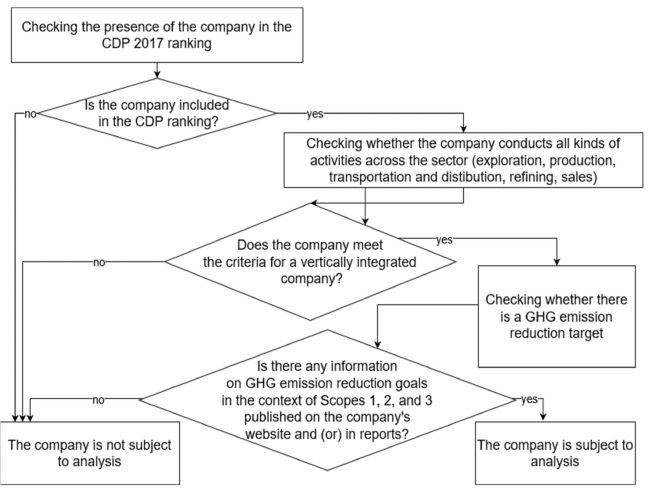
Figure 1. An algorithm for selecting oil and gas companies for the analysis. Source: compiled by the authors.